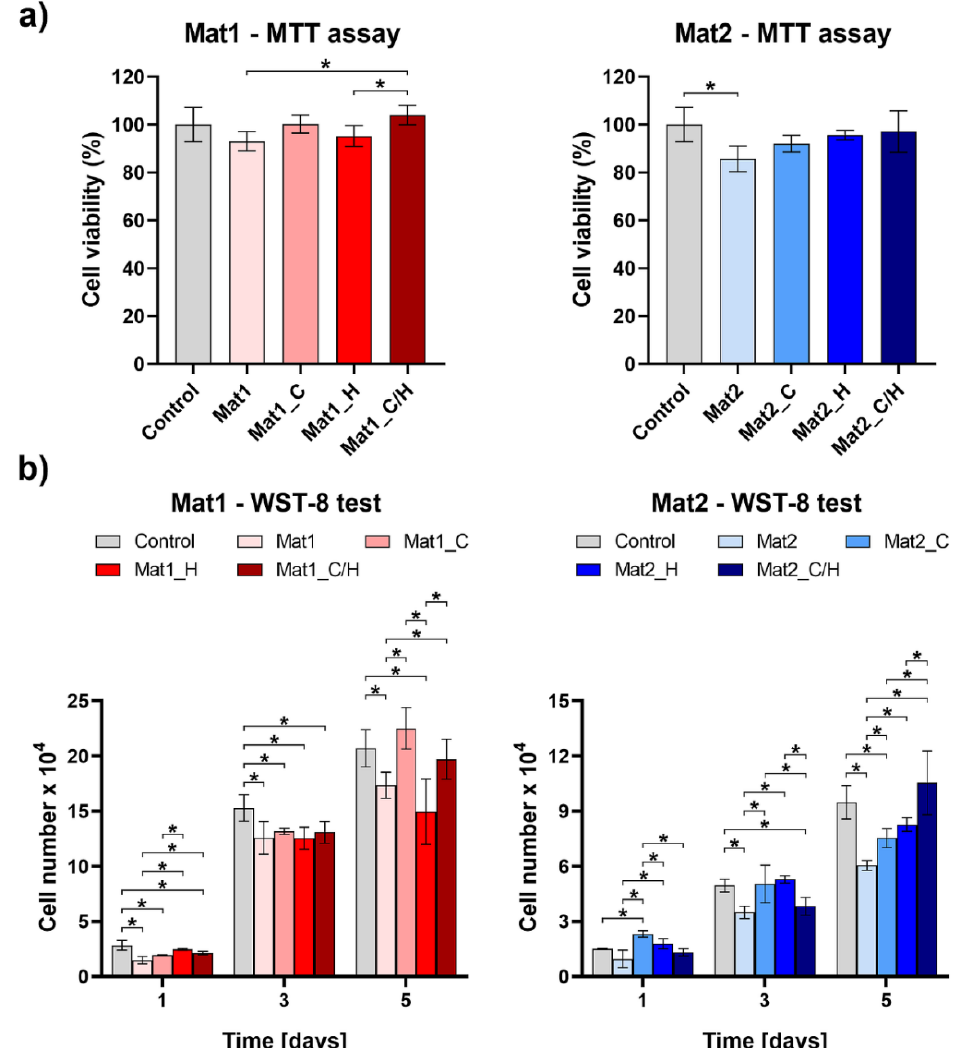
Figure 2. Response of human skin fibroblasts (BJ cell line) to biomaterials: ( a ) cell viability assessment after exposure to 24-h extracts of biomaterials (control–polystyrene extract); ( b ) cell proliferation assessment in a two-compartment environment using cell culture inserts (control–BJ cells cultured in the inserts without any biomaterial); * statistically significant results between indicated groups, n = 3, p < 0.05, one-way ANOVA followed by Tukey’s test (Mat1: curdlan/agarose